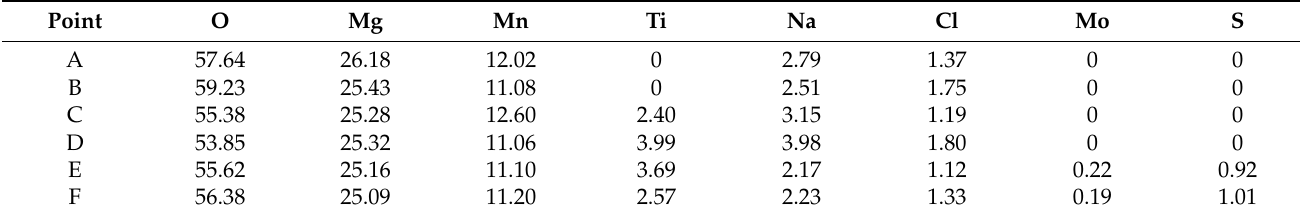
Table 4. Energy spectrum analysis of neutral salt spray test products (at. %).